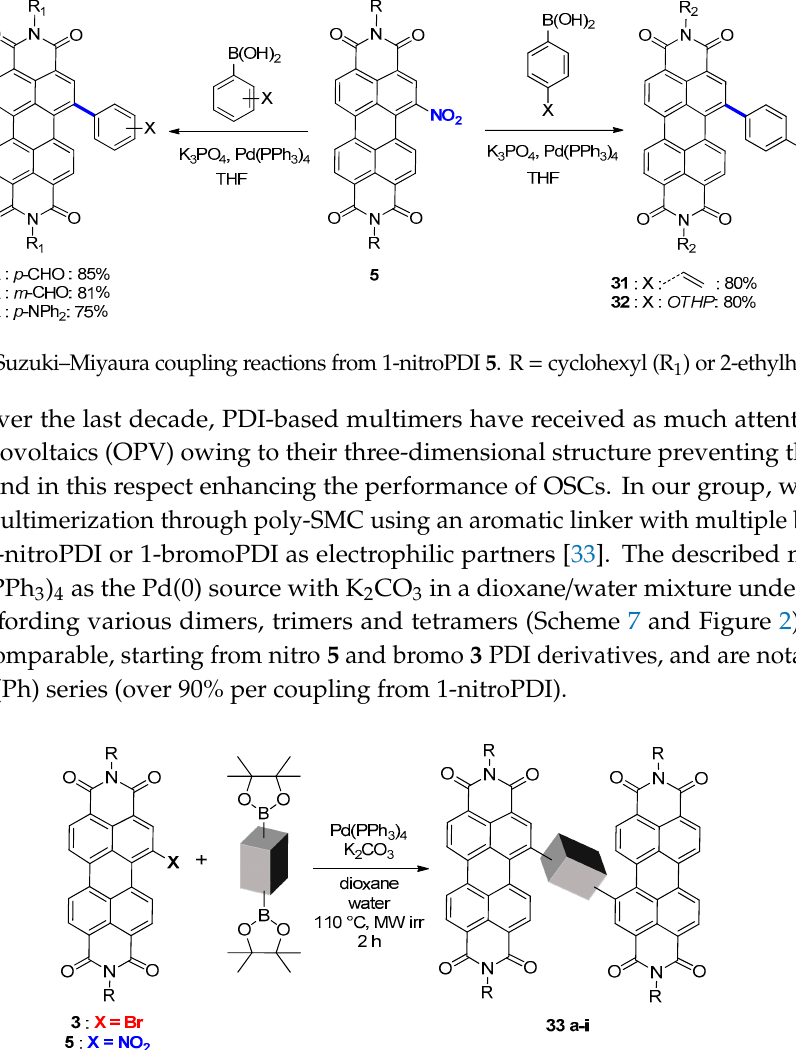
Figure 2. Schematic structures of PDI-based multimers obtained through SMC from 1-nitroPDI 5 and 1-bromoPDI 3 . Figure adapted with permission from reference 57. Copyright (2019) John Wiley and Sons. However, when the multimerization conditions were applied to enriched N -annulated bromo- or nitro-PDIs 34 and 35 in the presence of bis-boronate phenylene, significantly different reaction behaviors were observed (Scheme 8). The reaction carried out with bromo derivative 34 was clean and complete, whereas when applied to nitro-PDI 35 , the product 36 was obtained in 24% yield with 40% of starting material 35 recovered. This result coupled with theoretical calculations suggests that the limiting step of the coupling, the oxidative addition, is favored with the bromo derivative. Nevertheless, the electron-deficiency of the PDI core seems to promote this step, as no significant difference was noticed between the two electrophilic derivatives 3 and 5 during the parent PDI